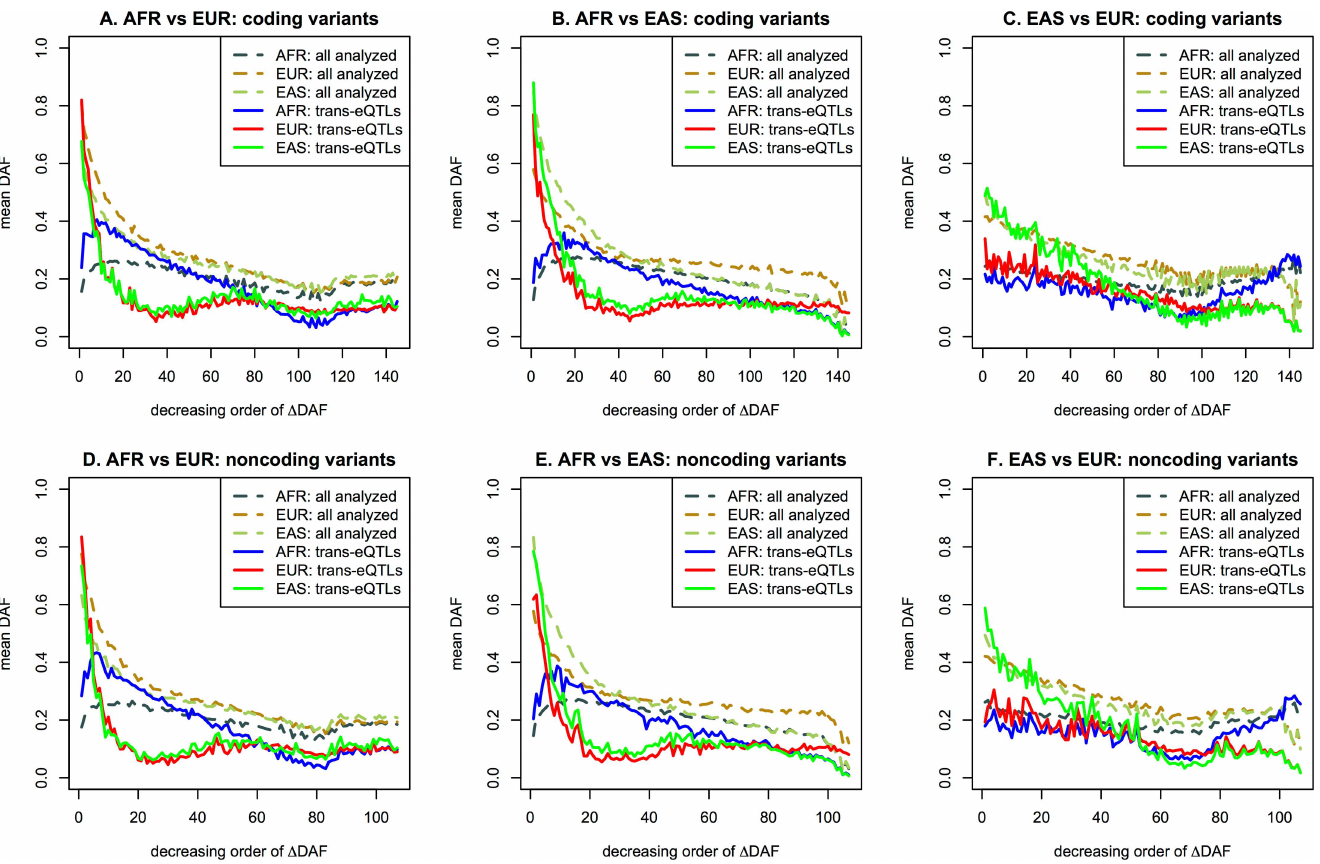
Fig 5. Mean DAFs in groups with decreasing Δ DAF: (a) AFR vs EUR: coding genes; (b) AFR vs EAS: coding genes; (c) EAS vs EUR: coding genes; (d) AFR vs EUR: noncoding genes; (e) AFR vs EAS: noncoding genes; (f) EAS vs EUR: noncoding genes.